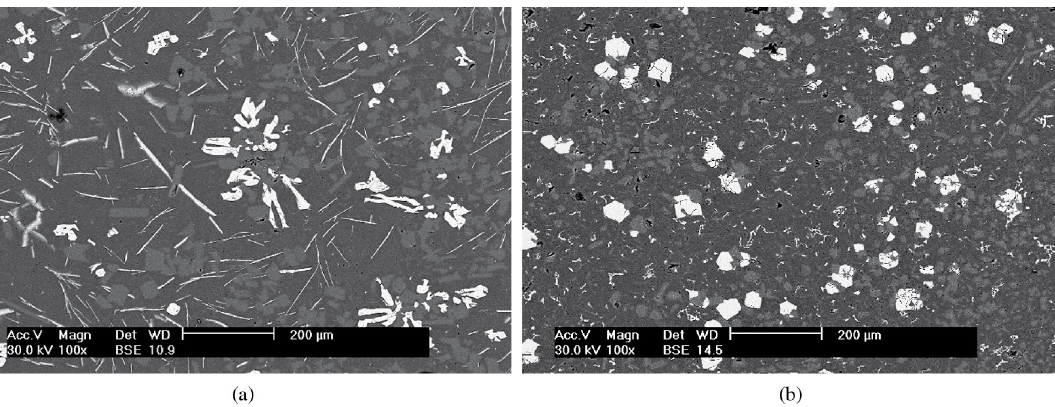
Figure 4. (a) BSE CS-cast micrographs of A1 alloy; (b) BSE CS-cast micrographs of A2